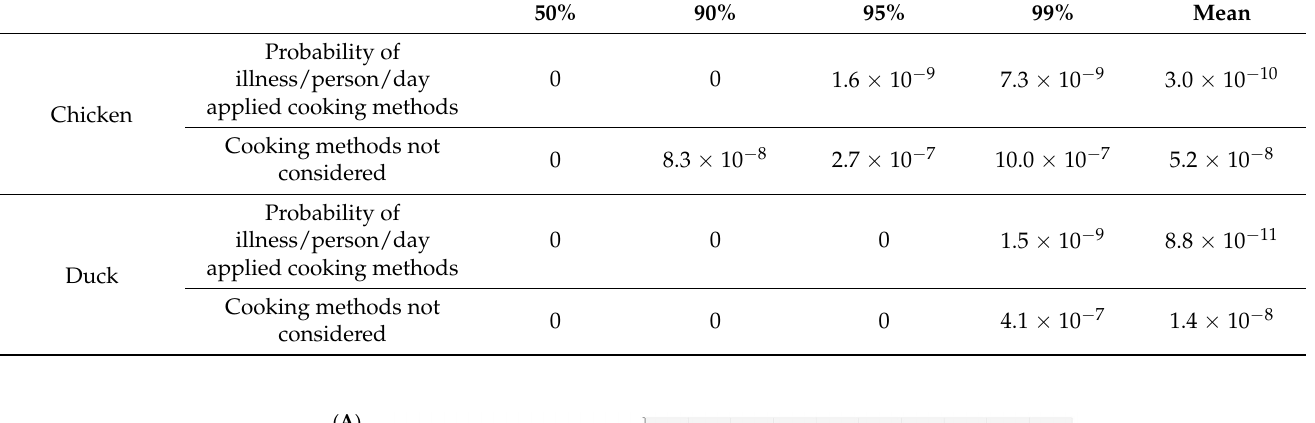
Table 3. Probability of Salmonella spp. foodborne disease per person per day resulting from consump- tion of chicken and duck.